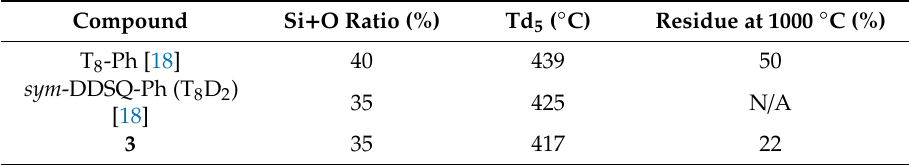
Figure 3. TG/DTA results obtained under nitrogen atmosphere. Heating rate is 10 °C/min. Table 2. TG/DTA results obtained under nitrogen atmosphere.